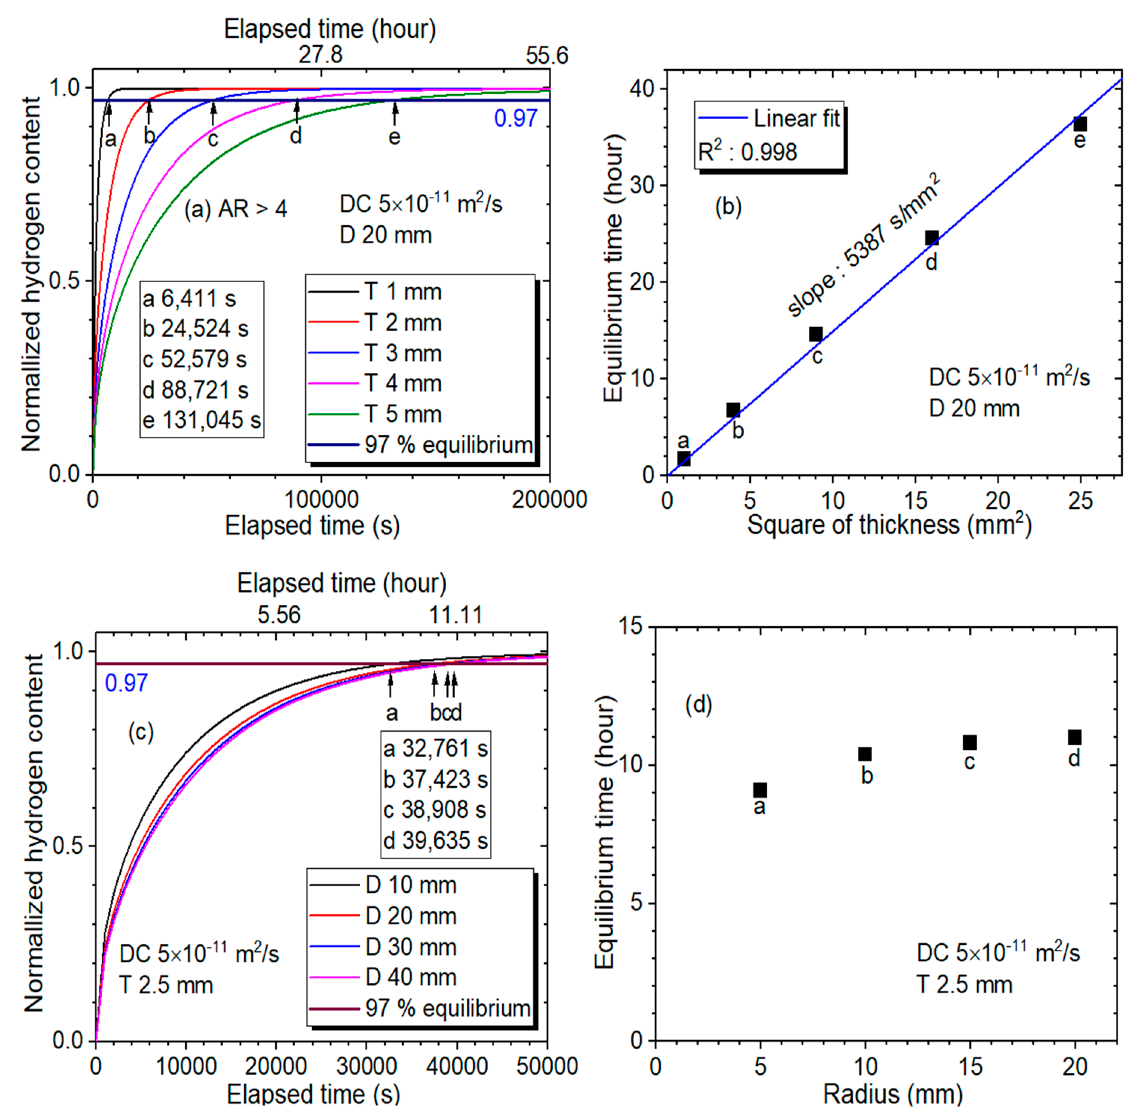
Figure 10. Numerical simulation for ( a ) normalized hydrogen content versus elapsed time with different thicknesses, ( b ) linear correlation between equilibrium time and square of thickness, ( c ) normalized hydrogen content versus elapsed time with different diameters, and ( d ) equilibrium time versus radius with a DC of 5 × 10 − 11 m 2 /s and thickness of 2.5 mm. D and T indicate the diameter and thickness of the cylindrical-shaped specimen, respectively. a, b, c, d and e are equilibrium time. DC—diffusion coefficient.